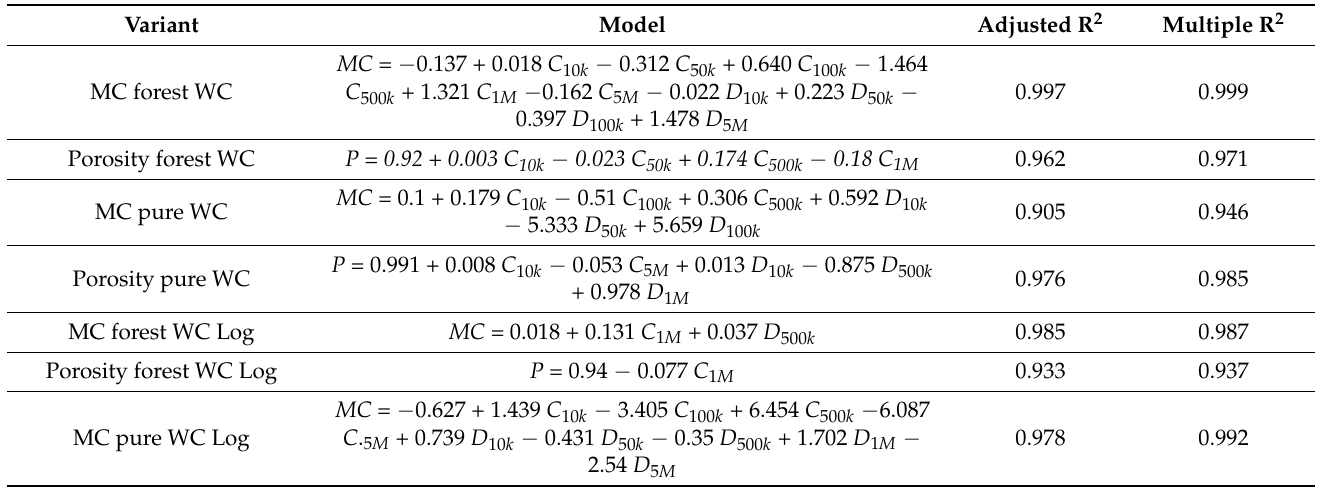
Table 3. Linear models for moisture content (MC) and porosity (P) determined by backward stepwise linear regression. C—electrical capacitance, D—dissipation factor, WC—wood chips.